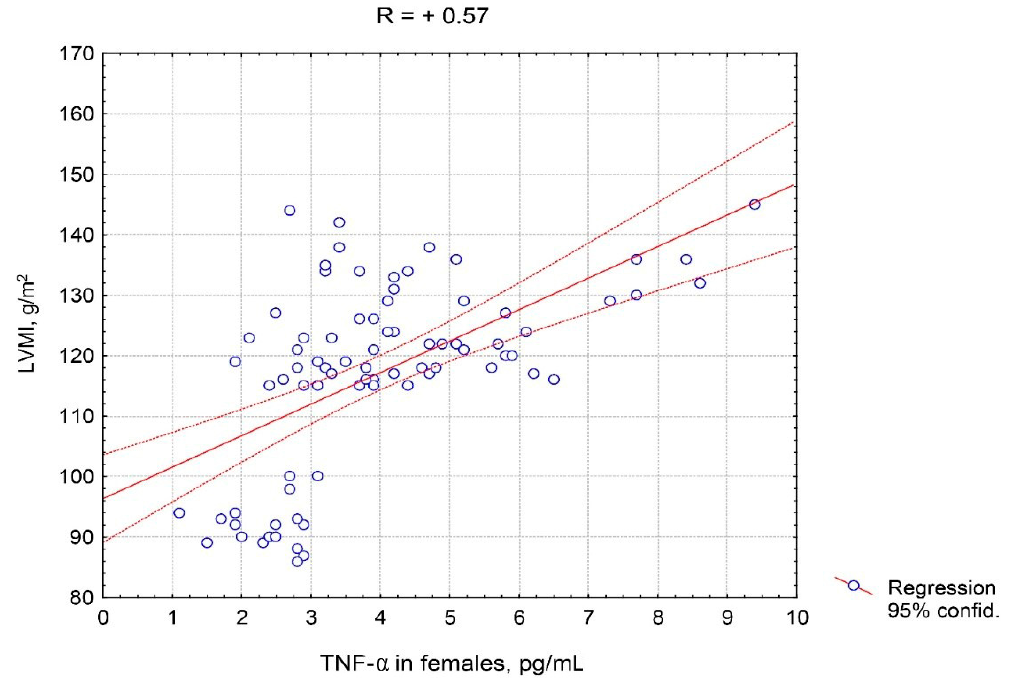
Figure 5. Correlative association of tumor necrosis factor alpha serum levels and left ventricular myocardial mass index in females with hypertension complicated by CHF with preserved left ventricular ejection fraction. Abbreviations: TNF- α : tumor necrosis factor alpha, LVMI: left ventricular myocardial mass index.